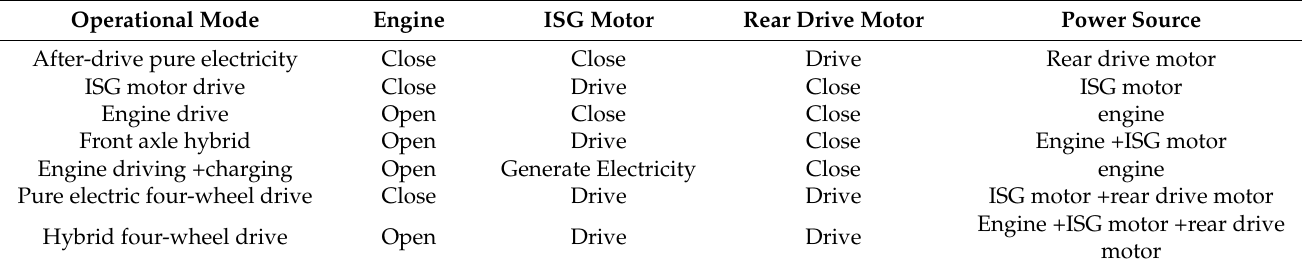
Table 4. Working states of components corresponding to different modes.